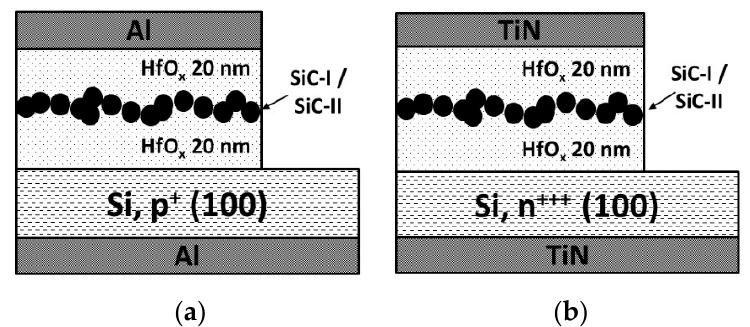
Figure 2. Sample devices fabricated for this study: ( a ) NC-MIS and ( b ) NC-MIM types.